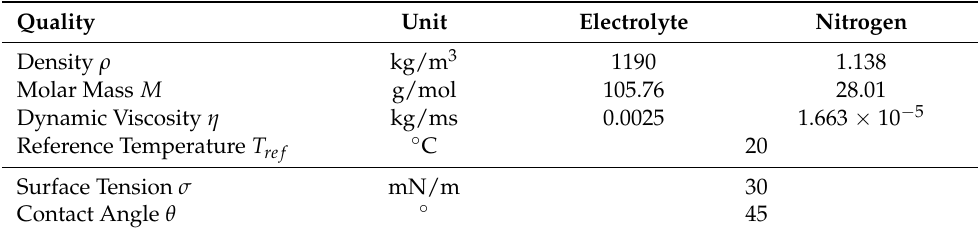
Table 1. Material properties of the electrolyte (LP572) [34] and nitrogen [35] for the micro and macro simulations.